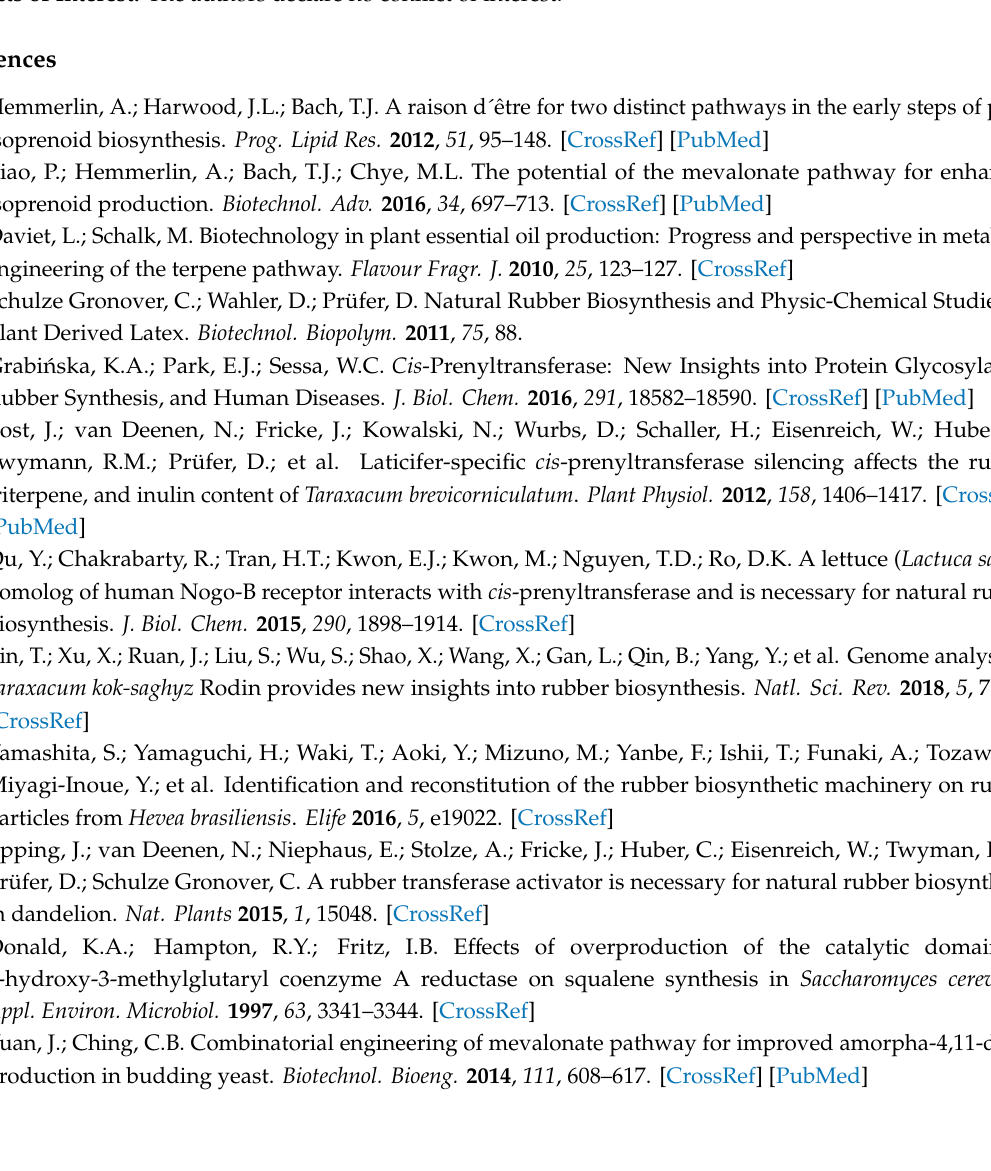
Figure S1: Sequence alignments and sequencing data corresponding to the LPP1 and DPP1 knockout strains, Table S1: oligonucleotides used to generate the guide RNA expression cassette in pML104 plasmids or for stop codon integration, Table S2: Yeast strains used to enhance the metabolic flux towards FPP and the corresponding sterol- and farnesol / germacrene-A